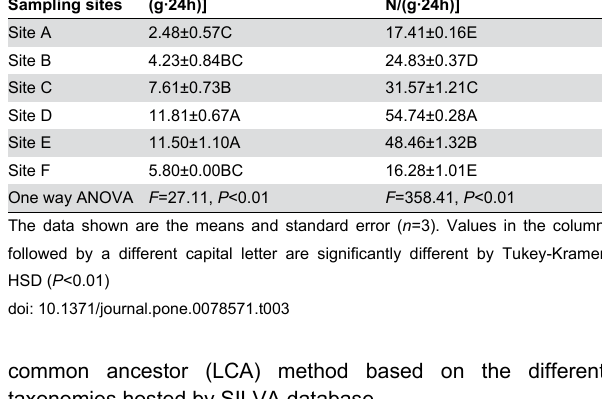
Table 3. Urease and protease activities in the sediments from each six sampling sites (site A, site B, site C, site D, site E, site F) in the Zhou cun drinking water reservoir, eastern China.